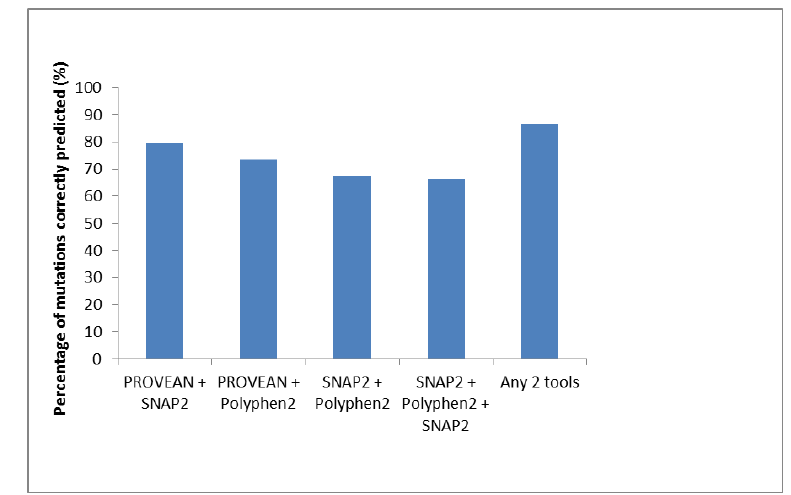
Figure 1. Percentage of mutations previously shown to be deleterious that were identified by the various prediction tools. The three prediction tools were also used to predict mutations that were functionally characterized and found to be neutral in literature. PROVEAN predicted 18 out of 32 mutations (56.3%) to be neutral at a cutoff of − 2.5, whereas 8 (25%) were neutral at a cutoff of − 1.3. PolyPhen2 and SPAN2 predicted 23 (71.9%) and 11 (34.4%) as neutral, respectively. In total, 16 (50%) and 10 (31.3%) mutations were predicted by at least two prediction tools as neutral at PROVEAN cut off − 2.5 and − 1.3. (Table 2). The prediction scores on the neutral aa variants were low because it depends on the assays, which were used and most of the times studies are not exhaustive. Table 2. Predicted effects of functionally characterized neutral mutations of HBV from literature.